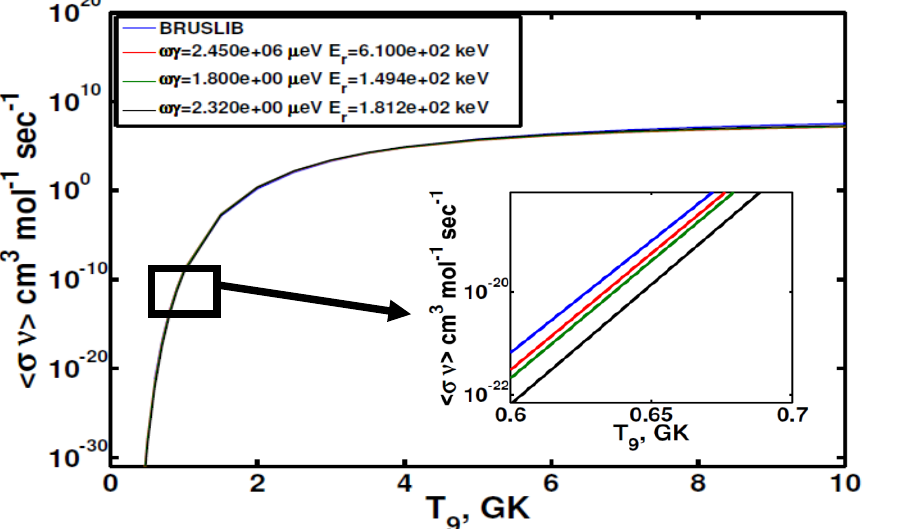
Figure 1: Reaction rates calculated using epera.m code for resonance values of Table 1, plotted with the theoretical values taken from BRUSLIB [10]. Only 3 examples are